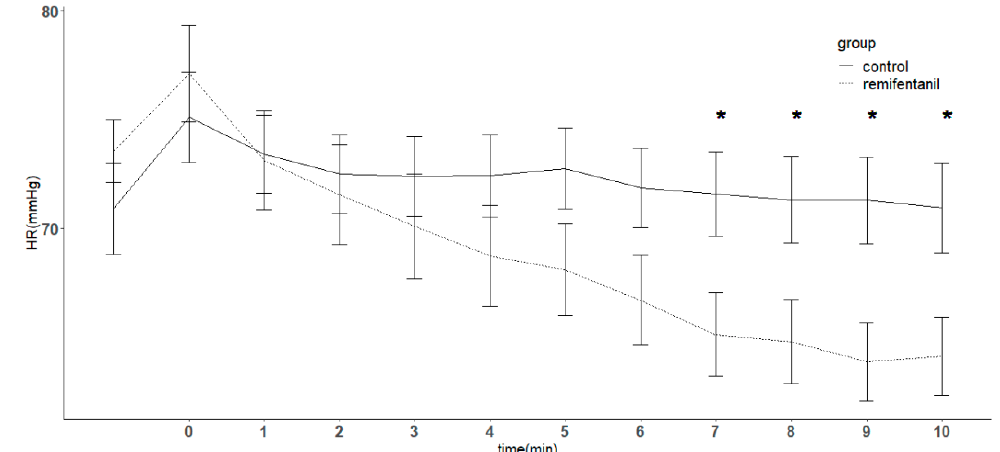
Figure 5. Changes in heart rate (HR) in patients with or without remifentanil infusion. In unconscious patients with propofol at the target effect-site concentration of 5 μ g/mL, a remifentanil target effect-site concentration of 5 ng/mL was infused in the remifentanil group throughout the study period. The control group received normal saline instead of remifentanil. HR decreased over time and an interaction was observed ( p < 0.05). There was no difference between the remifentanil group and control group, although the remifentanil group showed a significantly lower heart rate at 7, 8, 9, and 10 min. Error bar indicates standard error. In the x axis, time point 0 indicates the time the remifentanil infusion was started at an effect-site concentration of 5 ng/mL. * denotes p < 0.05 compared with the control group at the corresponding time point.